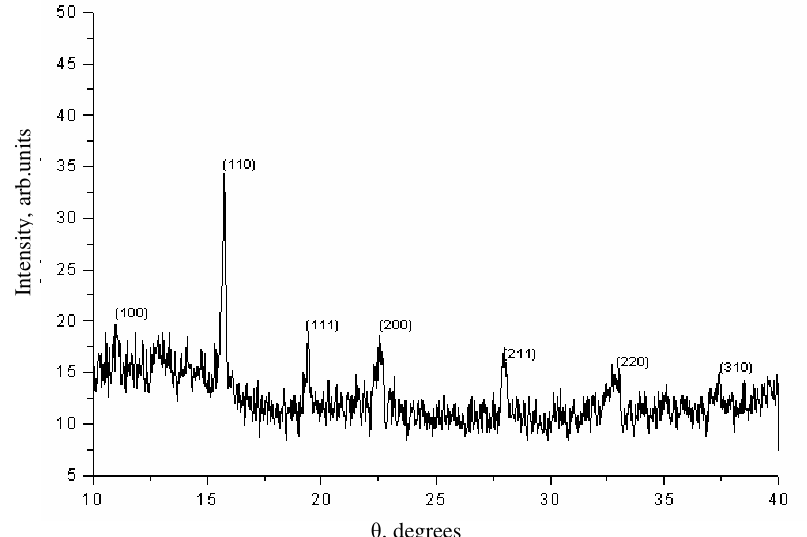
Figure 1. XRD pattern of BaTiO